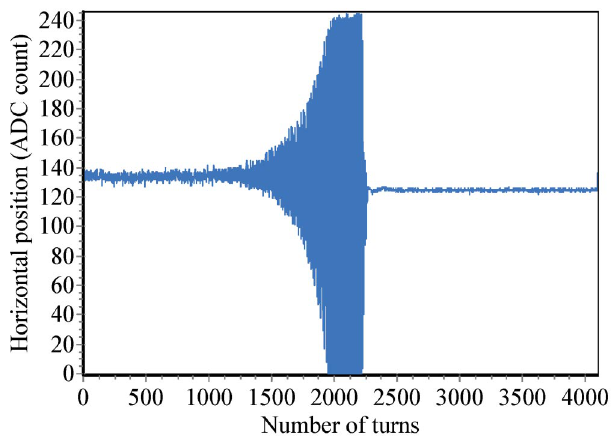
FIG. 3. (Color) Growth of the horizontal oscillation without a solenoid field.